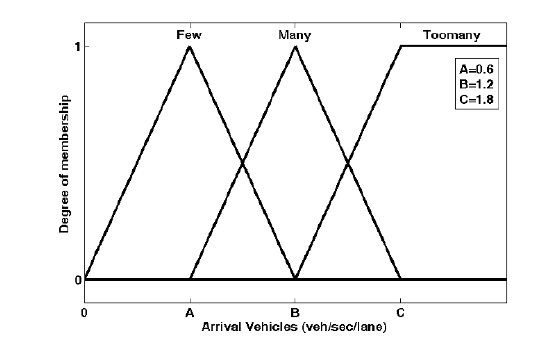
Figure 5. Fuzzy membership functions for AJGS